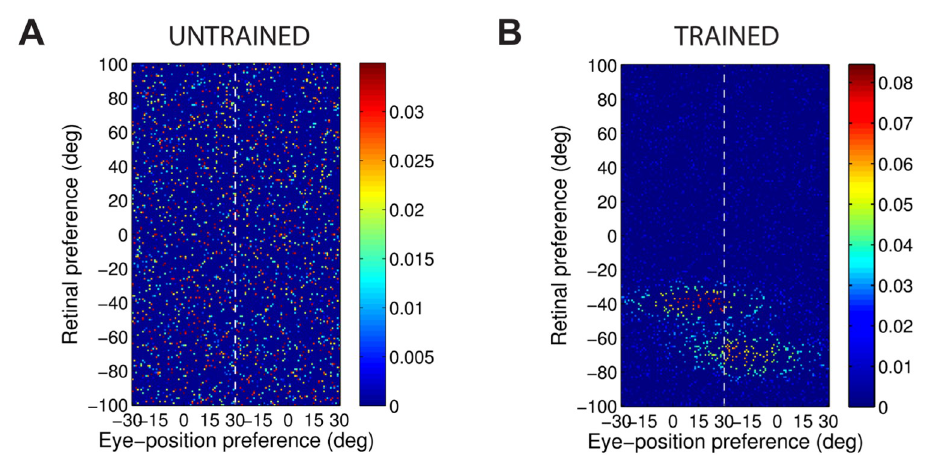
Fig 22. Simulation results showing the strengths of the afferent synapses of a model incorporating a population of sigmoidal modulated input neurons trained with the modified learning rule 20: Delayed postsynaptic trace learning rule. The figure shows the strengths of the afferent synapses from the input population to output neuron #223 for the untrained (A) and trained (B) model. The output neuron corresponds to the one plotted in Fig 21. Conventions as for Fig 13. The synaptic weight structure for this output neuron after training shown in plot (B) has approximately the correct profile for a head-centred neuron (Fig 8). numbers of head-centred output neurons when all of the input neurons have sigmoidal eye- position gain fields.